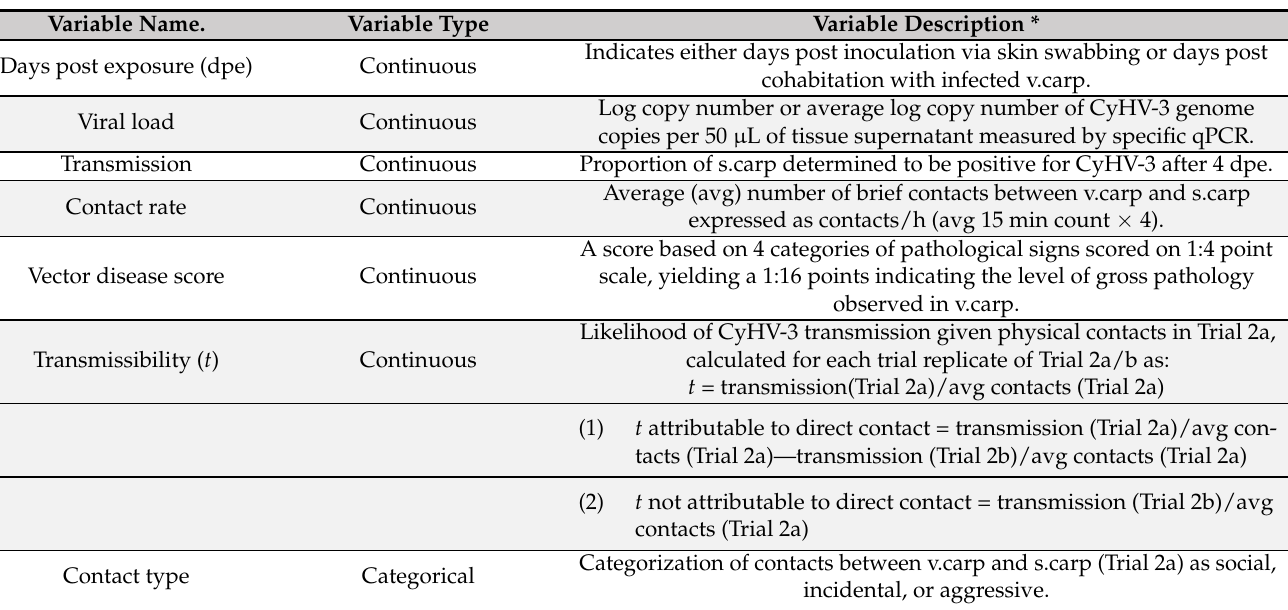
Table 2. Variables measured in this